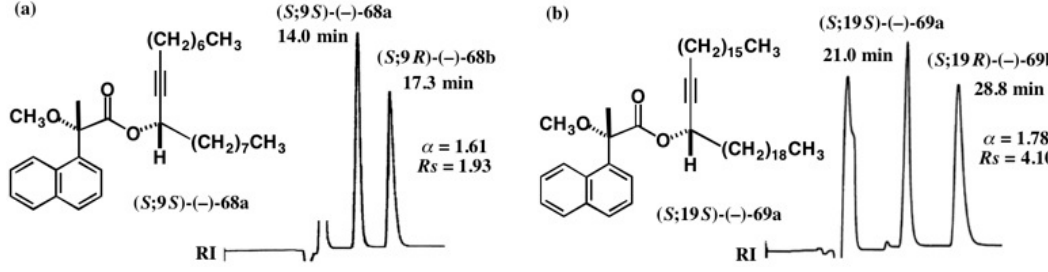
Figure 47. HPLC separation of diastereomeric M α NP esters of long chain internal acetylene alcohols: ( a ) 68a / 68b , hexane/EtOAc 20:1, reprinted from [61]; ( b ) 69a / 69b , hexane/EtOAc 50:1, reprinted with permission from [62].